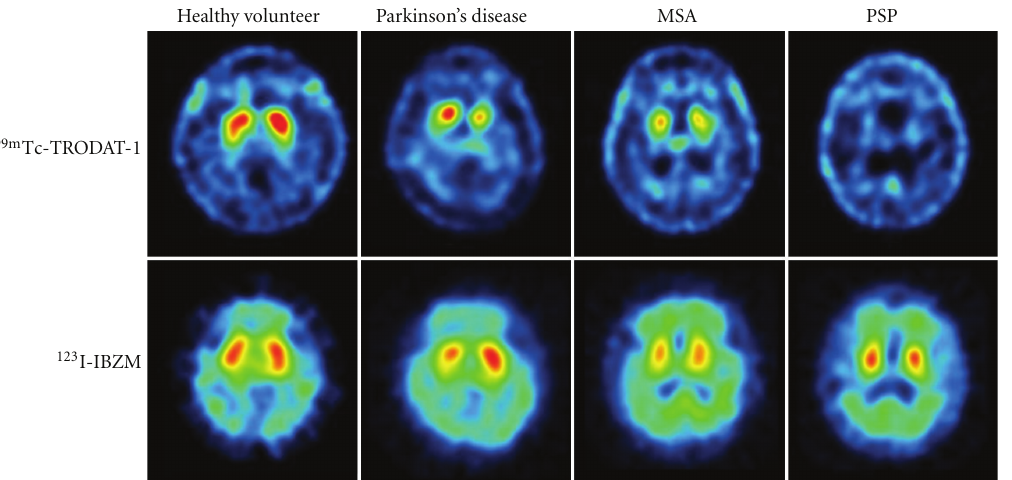
Figure 2: Dopamine transporter (DAT) imaging with 99m Tc-TRODAT-1 and dopamine D 2 receptor imaging with 123 I-IBZM of healthy volunteer and patients with Parkinson’s disease (PD), multiple-system atrophy (MSA), and progressive supranuclear palsy (PSP). The striatal DAT uptakes were significantly decreased in patients with PD, MSA, and PSP, whereas the dopamine D 2 receptor uptakes were mildly decreased in patients with PD, MSA, and